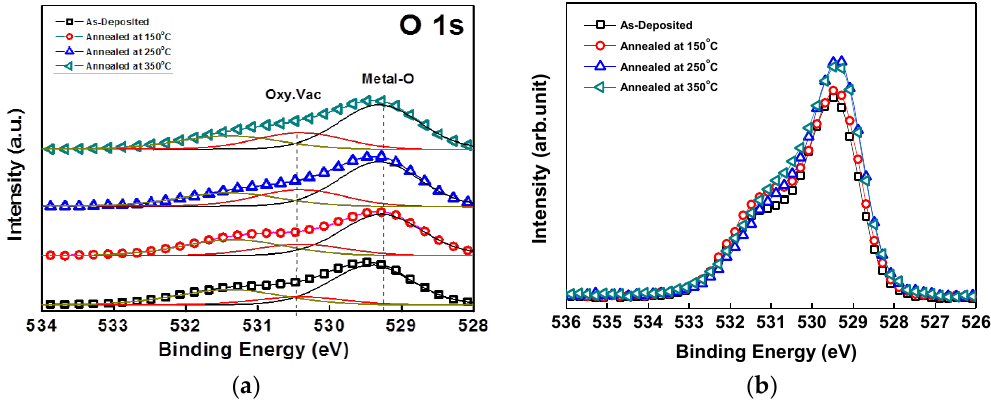
Figure 3. X-ray photoelectron spectroscopy (XPS) spectra of ( a ) detailed and ( b ) O 1s for IZTO films at various annealing temperatures in the range of 150–350°C. Metal-O: metal oxide; Oxy. Vac: oxygen vacancy.